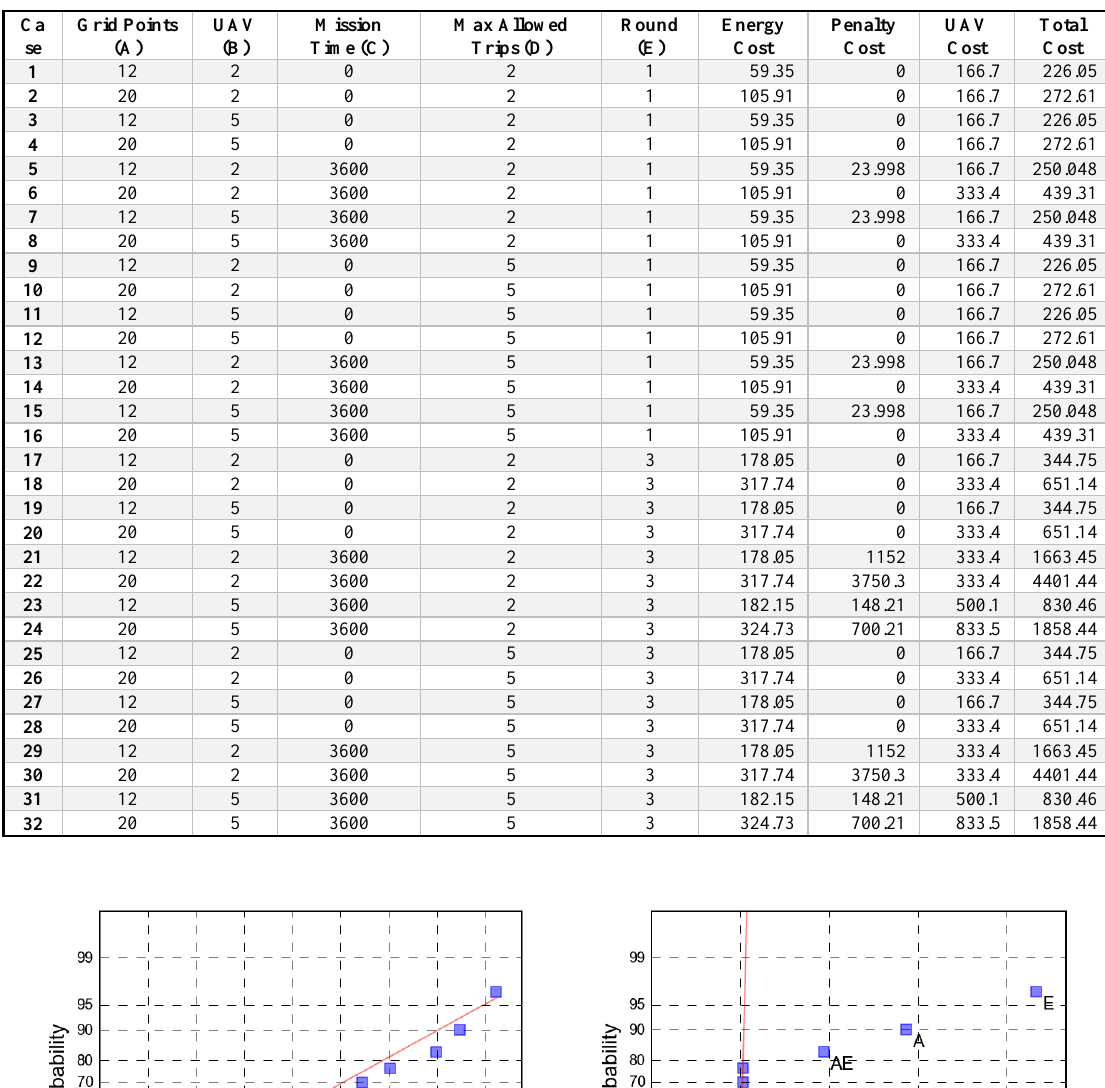
Table 5. Results from the single-replicate 2 5 factorial experiment.